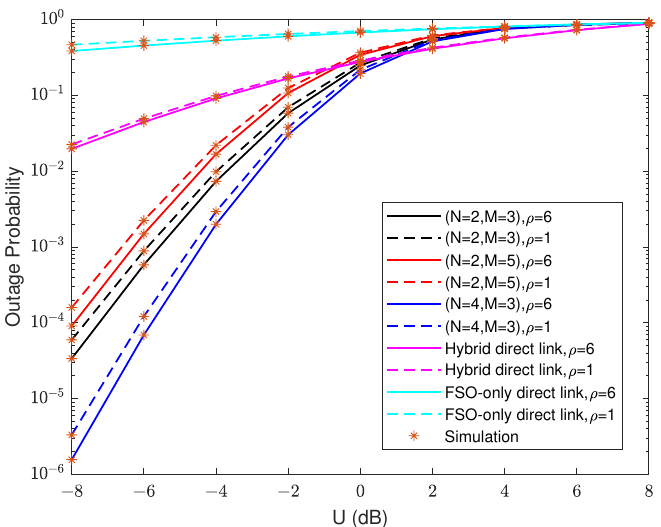
Figure 6. Relationship between outage probability and the normalized SNR of the multi-hop parallel hybrid FSO/RF system, the hybrid FSO/RF direct link, and the FSO-only direct link under different relay-assisted structures and pointing